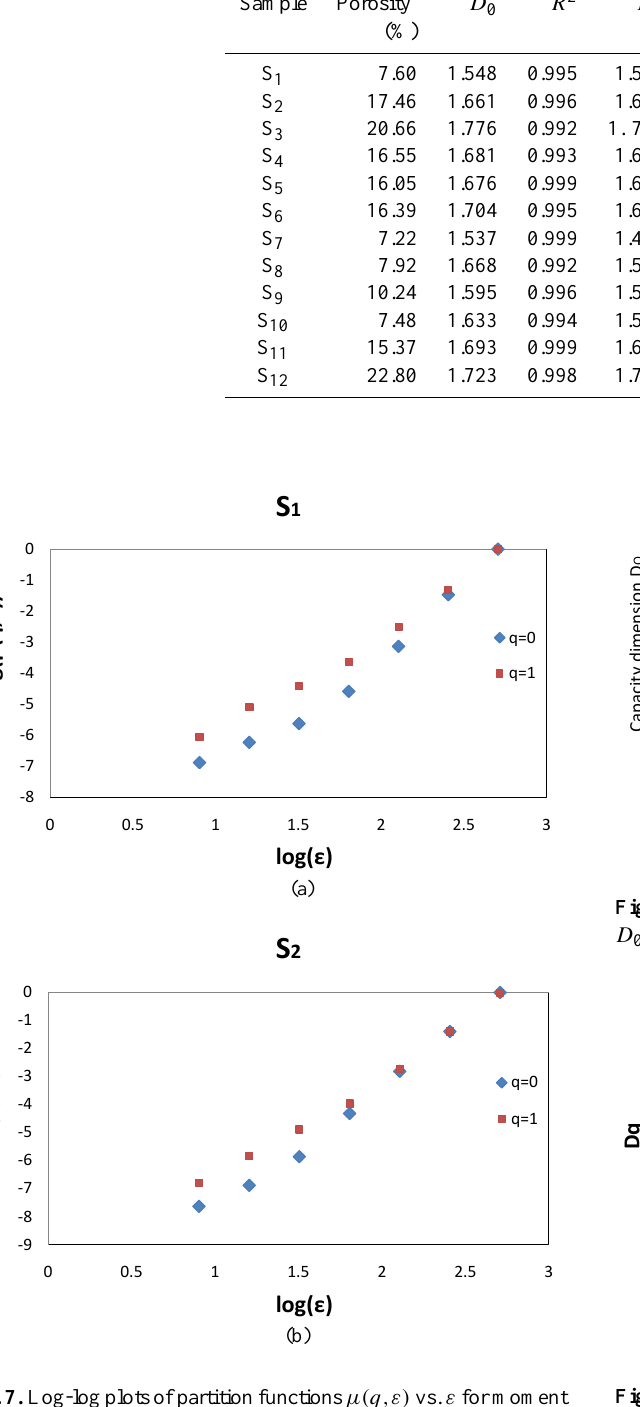
Fig. 7. Log-log plots of partition functions µ(q,ε) vs. ε for moment Figure 7. Log-log plots of partition functions ),(  q vs  for moment order q=0 and q=1 for 4 order q=0 and q=1 for Sample S 1 and Sample S 2 , respectively, in (a) and (b) . Sample S 1 and Sample S 2 respectively in (a) and (b). 5